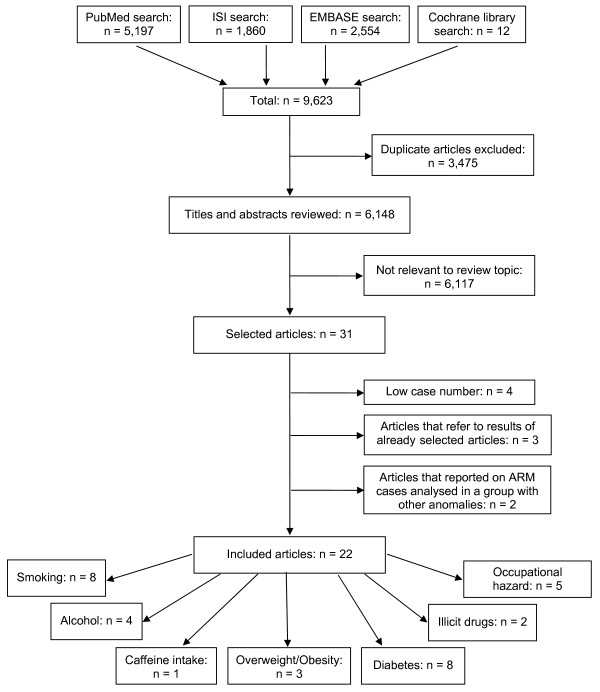
Flow diagram of the literature search process.